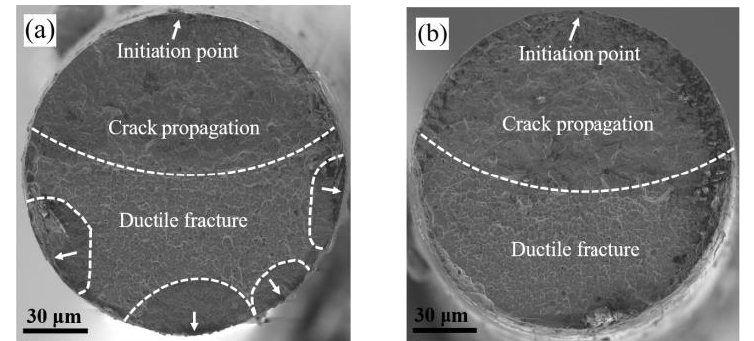
Figure 13. Fracture surface of the nanocrystalline (NC) NiTi wire: ( a ) as-received, and ( b ) trained. The initiation points of the cracks are marked with white arrows.